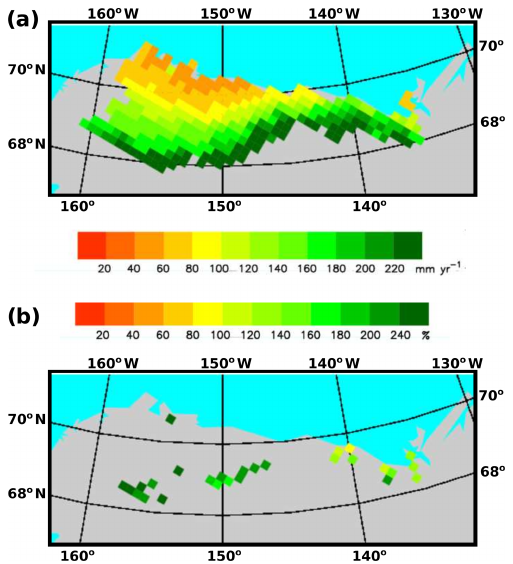
Figure 5. (a) Annual total R 1981–2010 (mmyr − 1 ) from the model simulation and (b) grid cells with a statistically significant ( p < 0 . 05) change in simulated cold season (November–April) Q over the period 1981–2010. The change is shaded as a percentage of the 30-year average for cold season R for that grid. White outlines are basin boundaries for the (west to east) Colville, Kuparuk, and Saga- vanirktok